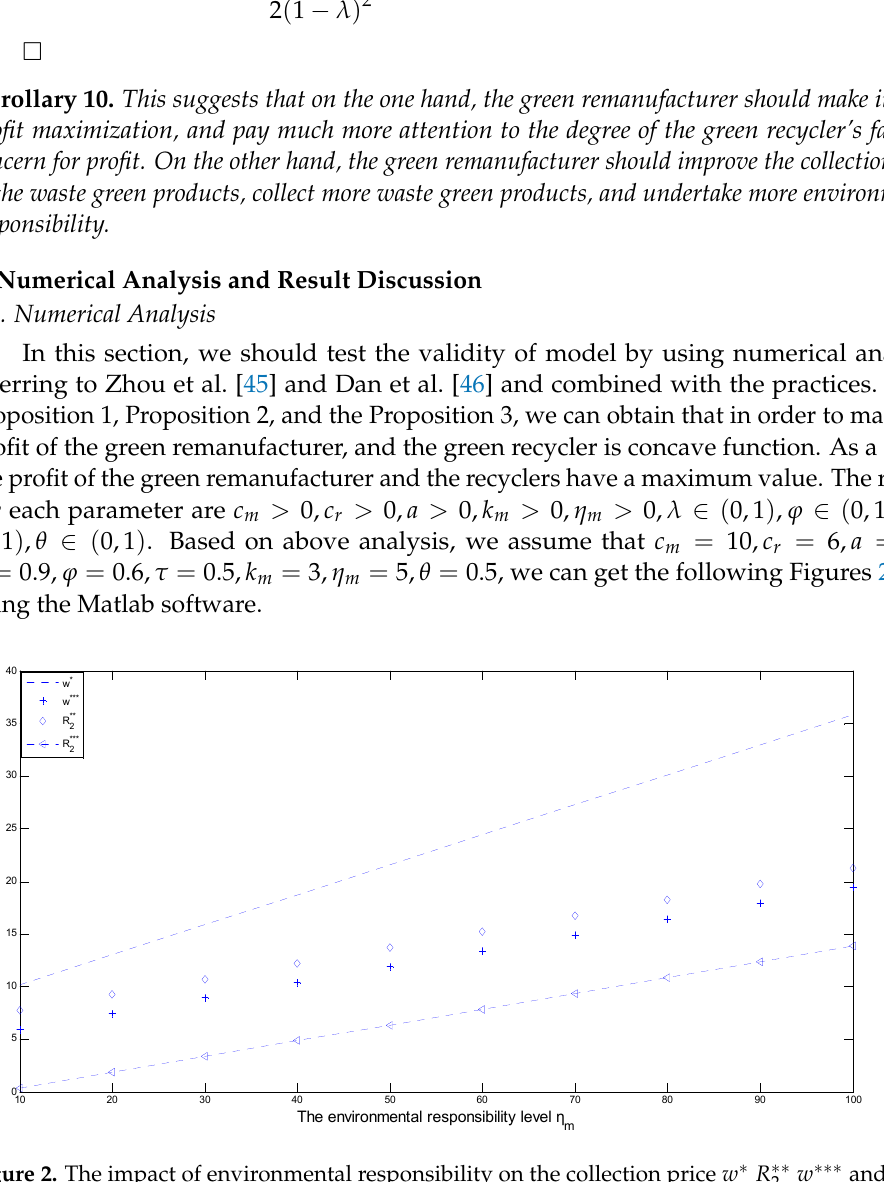
Figure 2. The impact of environmental responsibility on the collection price * w *** w